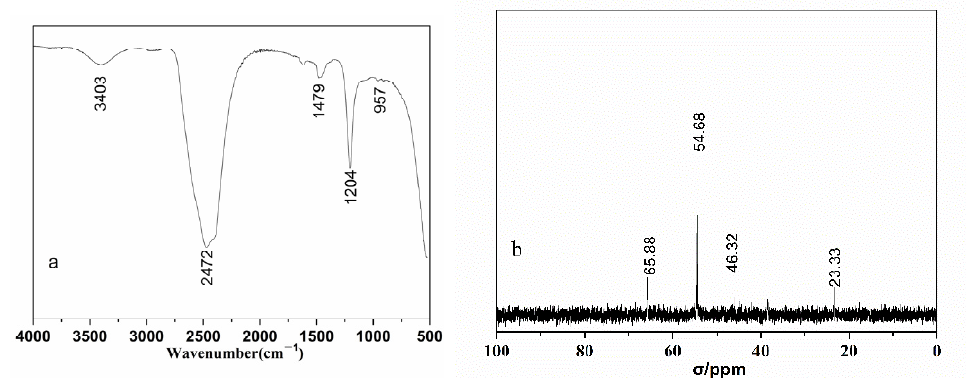
Figure 14. Infrared ( a ) and 13 CNMR ( b ) spectra of small molecules after PMAPTAC hydrolysis. From the infrared spectrum in Figure 14, it can be seen that the peaks at 957 cm − 1 and 1479 cm − 1 are N + (CH 3 ) 3 and methyl stretching vibration peaks on quaternary ammonium, respectively [30], and the stretching vibration at 1204 cm − 1 is the C-N stretching vibration of C-N + (CH 3 ) 3 [31–33]. The 2472 cm − 1 peak is attributed to the absorption peak of ammonium salt, which may be due to the interaction of HCl and primary amine-NH 2 on the small molecule generated by the hydrolysis of the amide bond. In addition, it can be seen in the carbon spectrum in Figure 14 that 54.68 ppm is attributed to the peak of the primary carbon atom in the methyl group of N + (CH 3 ) 3 , and 65.88 ppm, 46.32 ppm and 23.33 ppm are the peaks of the secondary carbon atom in the propyl group. Therefore, the amide bond of PMAPTAC was hydrolyzed into a carboxyl group, and the small molecule (3- aminopropyl)trimethylammonium chloride was